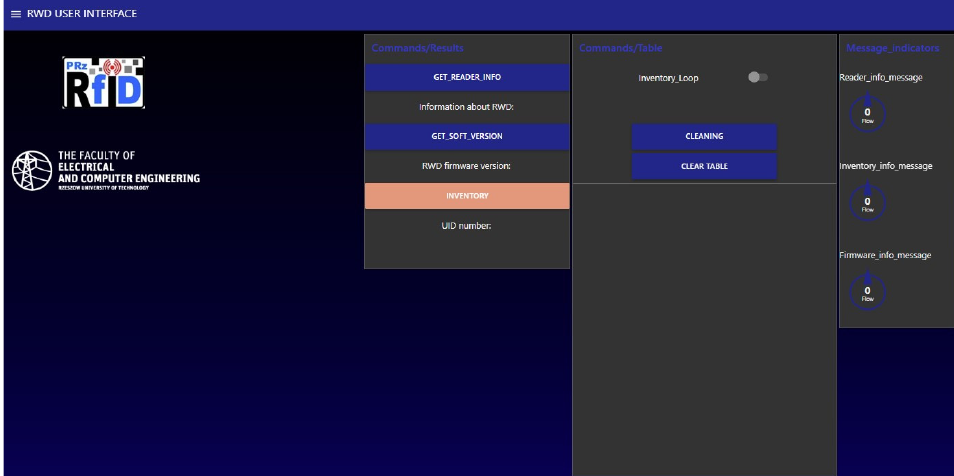
Figure 5. GUI conception by the authors.